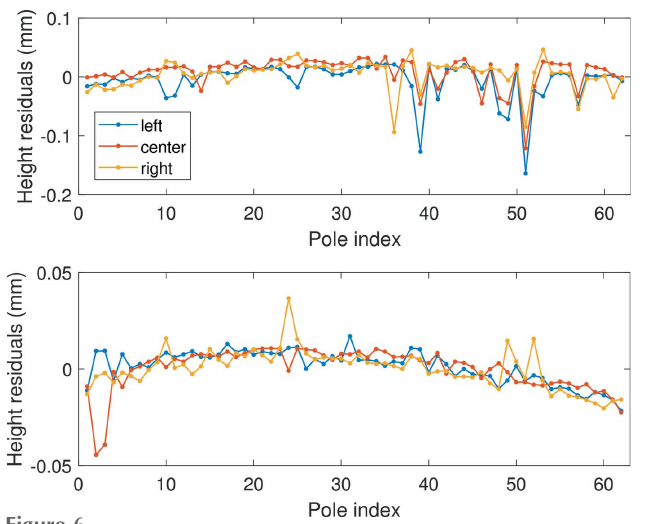
Residuals of the measured pole heights for one mock-up